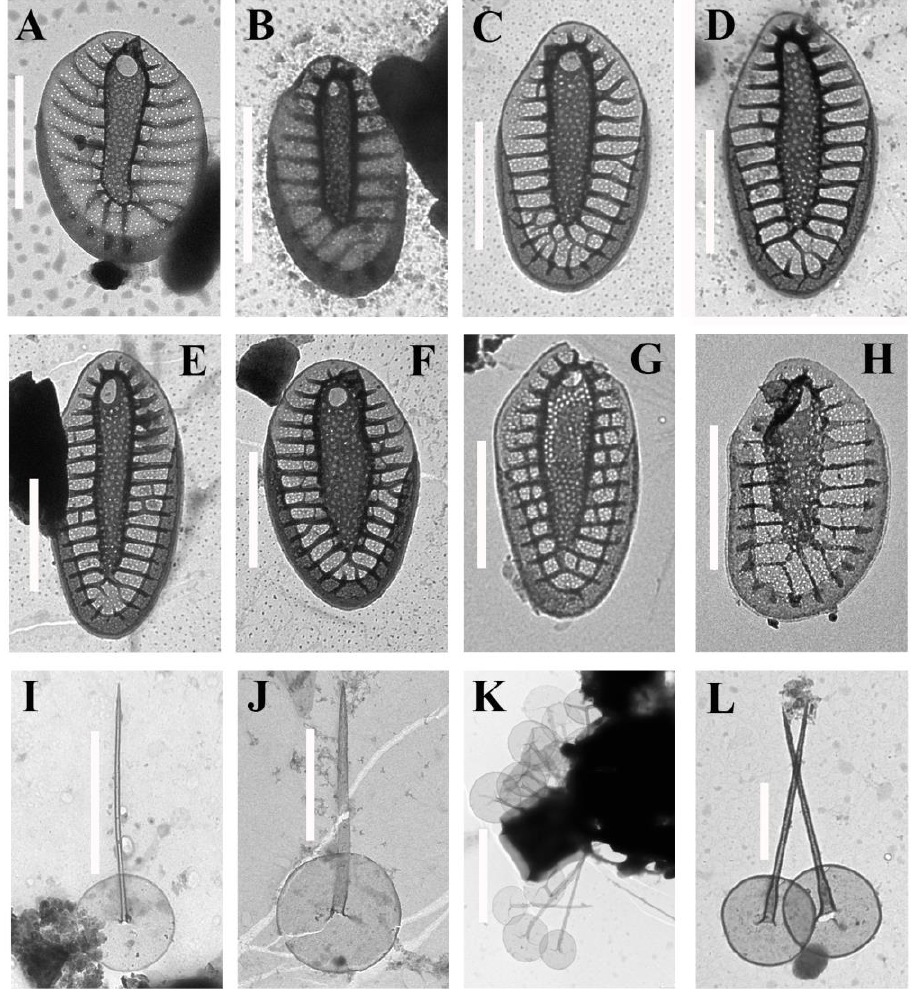
Figure 4. Synura and Paraphysomonas taxa from Teletskoye Lake and adjacent area , TEM. ( A , B ) Synura sp. 1, body scales; ( C – F ) Synura sp. 2, body scales; ( G ) Synura sp. 3, body scale; ( H ) Synura sp. 4, body scale; ( I ) Paraphysomonas sp. 1; ( J , K ) Paraphysomonas sp. 2; and ( L ) Paraphysomonas sp. 3. Scale bars: ( K ) : 5 μm; ( A – J , L ) : 2 μm. Table 2. List of silica-scaled chrysophytes found in this study; “+” indicates the presence of a taxon. Sample Sites * Taxon